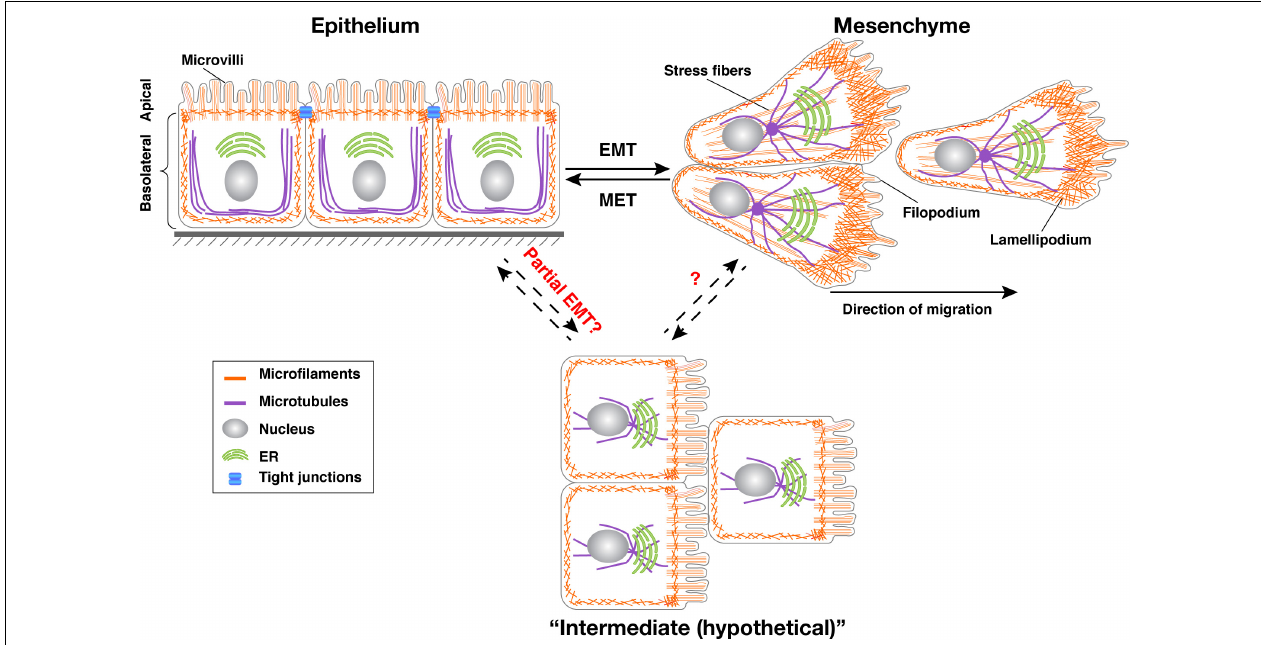
FIGURE 1 | Transitions between epithelial, mesenchymal, and intermediate cell states. Typical vertebrate epithelium structure with apicobasal polarity. Tight junctions separate the apical domain from the basolateral domain. Upon EMT, cells lose apicobasal polarity, reorganize their cytoskeleton, and become motile. Increasing evidence shows that cells undergo collective migration rather than individual migration after EMT. Both epithelial and mesenchymal states are plastic and mesenchymal cells can return to the epithelial state in both development and cancer situations through a process called MET. It is believed that cells, especially in cancer situations, can enter a “partial EMT” state where they express mixed epithelial and mesenchymal gene signatures. Microfilaments are indicated in red, microtubules in green. The position of the nucleus (light blue oval) is also